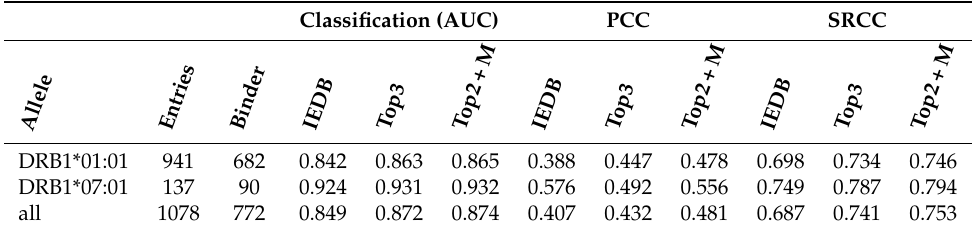
Table 7. Performance of consensus predictions. Shown are the results reported by the IEDB bench- mark service for the IEDB consensus method (IEDB), a consensus-based on the predictions of NetMHCIIpan-3.1, NN-align, and SMM-align (Top3) and consensus-based on the predictions of NetMHCIIpan-3.1, NN-align, and MHCII3D (Top2 + M).